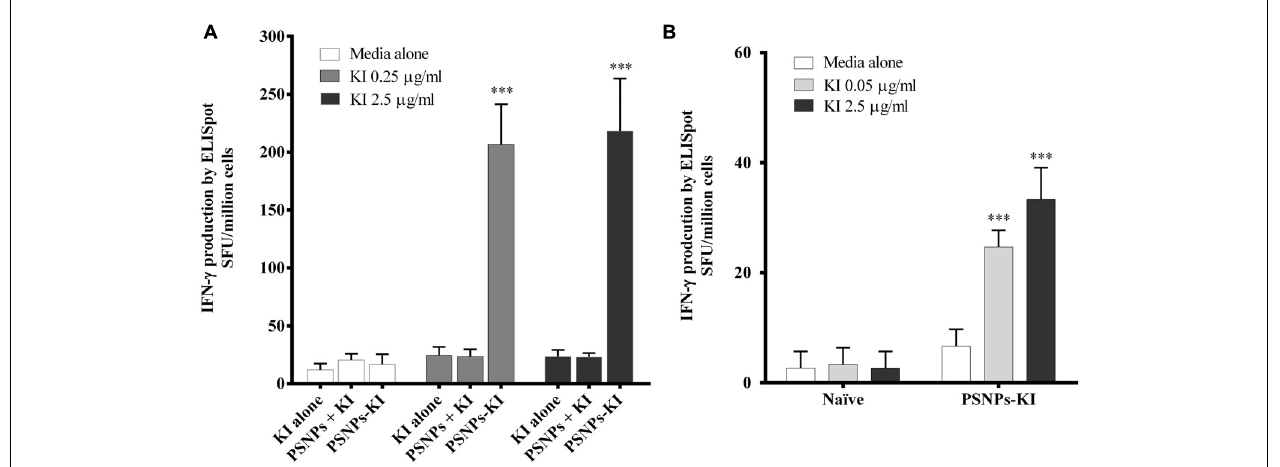
KI specific CD8T cell responses after two immunizations (2 weeks apart). Data presented as mean ± SD of SFU/million cells from each group ( n = 3 mice/group). (B) Immunogenicity of PSNPs-KI formulation after one immunization ( n = 4 mice per group). Data presented as mean ± SD of SFU/million cells (pooled for each group) from the triplicated wells in ELISpot assay. Statistical analysis was performed via ANOVA, *** p ≤ 0.001.